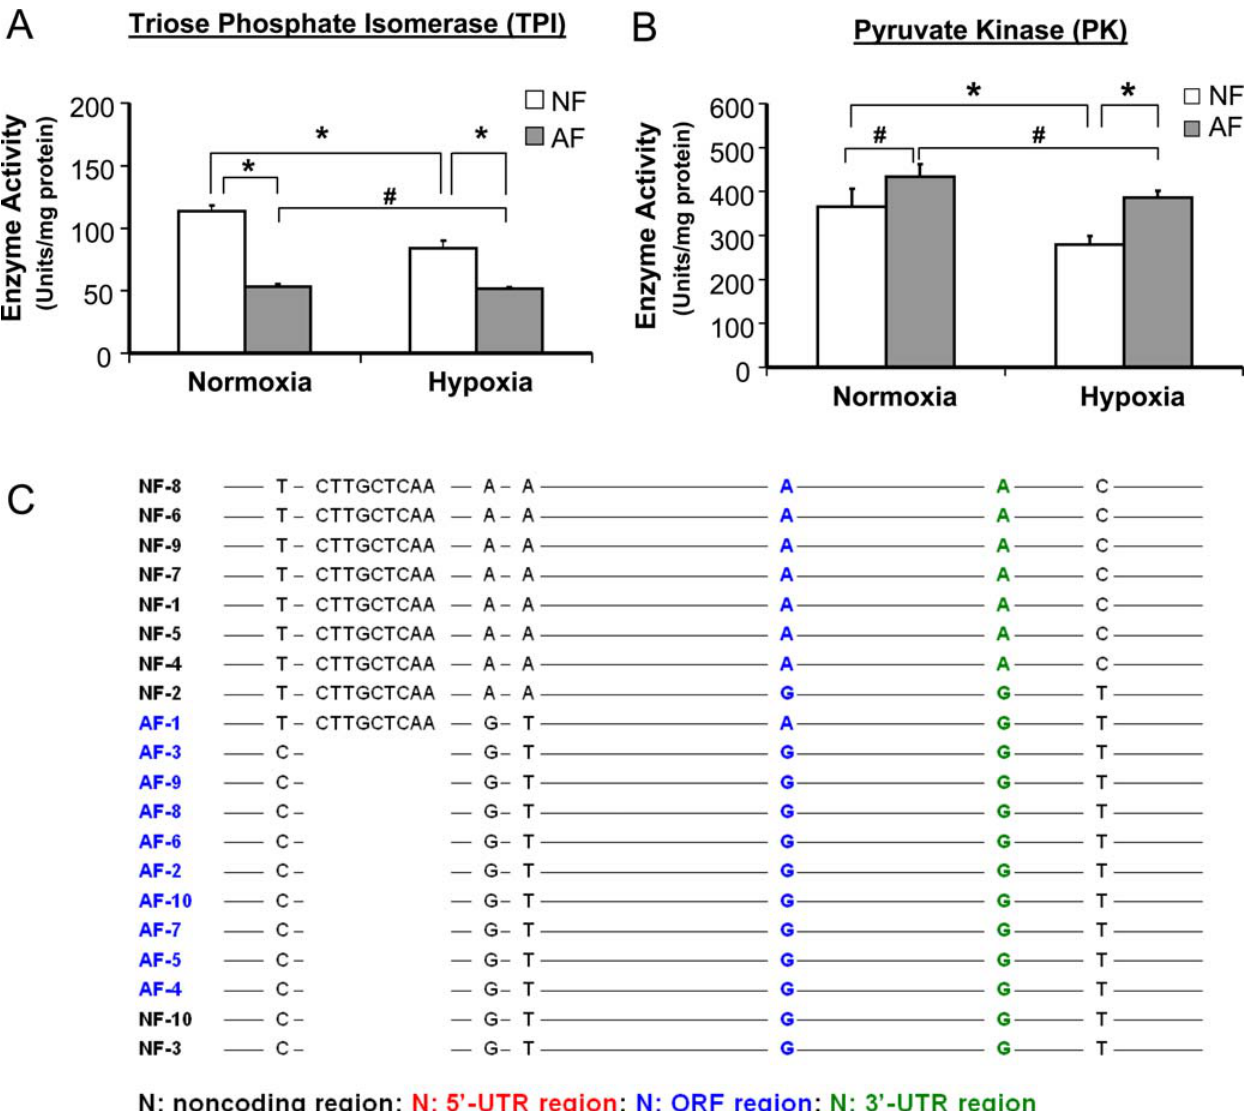
Figure 8. Differences in enzymic activities of triose phosphate isomerase and pyruvate kinase and allelic frequency between AF and NF. A) Enzymic activity and hypoxia response of TPI in AF and NF. TPI activity was measured in 3rd instar larvae of AF and NF cultured under either normoxia or hypoxia. AF had a significantly reduced enzymic activity than NF under both hypoxic and normoxic conditions. In contrast to the effect of hypoxia in NF, hypoxia did not induce a significant reduction on enzyme activity in AF. Data were presented as means 6 SD (* p , 0.05, # p . 0.05). B) Enzymic activity and hypoxia response of PK in AF and NF. The enzymic activity of PK was measured in 3 rd instar larvae of NF and AF cultured under either normoxia or hypoxia. There was no significant difference in PK activity between AF and NF cultured under normoxia. Hypoxia induced a significant reduction of PK activity in NF but not in AF. Data were presented as means 6 SD (* p , 0.05, # p . 0.05). C) Comparison of allelic frequency in the genomic region of TPI gene between AF and NF. The genomic locus encoding TPI gene was amplified by high fidelity PCR using specific primers. The PCR products were purified and cloned into pCR4-TOPO plasmid to create a plasmid library for the TPI alleles of AF and NF populations. Ten clones from the AF or NF TPI allele library were sequenced and compared by using ClustalW2 software and DnaSP 4.0. The statistical power for the comparison was calculated by GPower software 3.0.3. Seven significant polymorphic differences were identified in the AF population that included 3 SNPs ( 2 77T/C, 2 53A/G, 2 51A/T) and 1 indel ( 2 74 to 2 66) in the cis -regulatory region, 1 synonymous SNP (1051A/G) in the coding region, 1 SNP (1480A/G) in the 3 9 -untranslated region, and 1 SNP (1662C/T) in the downstream region (p , 0.001, CHI-Test).